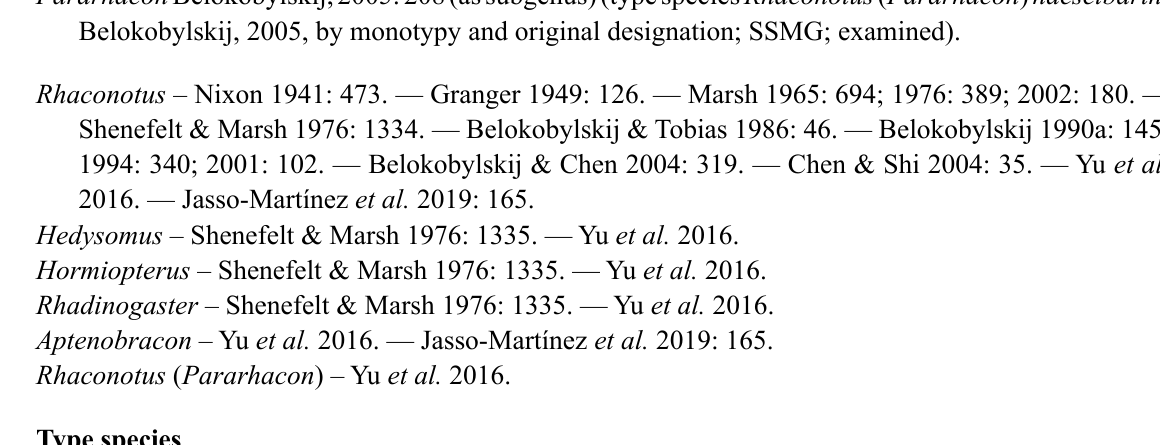
Palps usually rather long; maxillary palps 6-segmented, labial palps 4-segmented, its third segment not shortened. Scapus more or less wide, relatively long, without apical lobe and basal constriction, its ventral margin (lateral view) not longer than dorsal margin. First flagellar segment subcylindrical, usually at least weakly longer than second segment. Apical segment acuminate apically and without